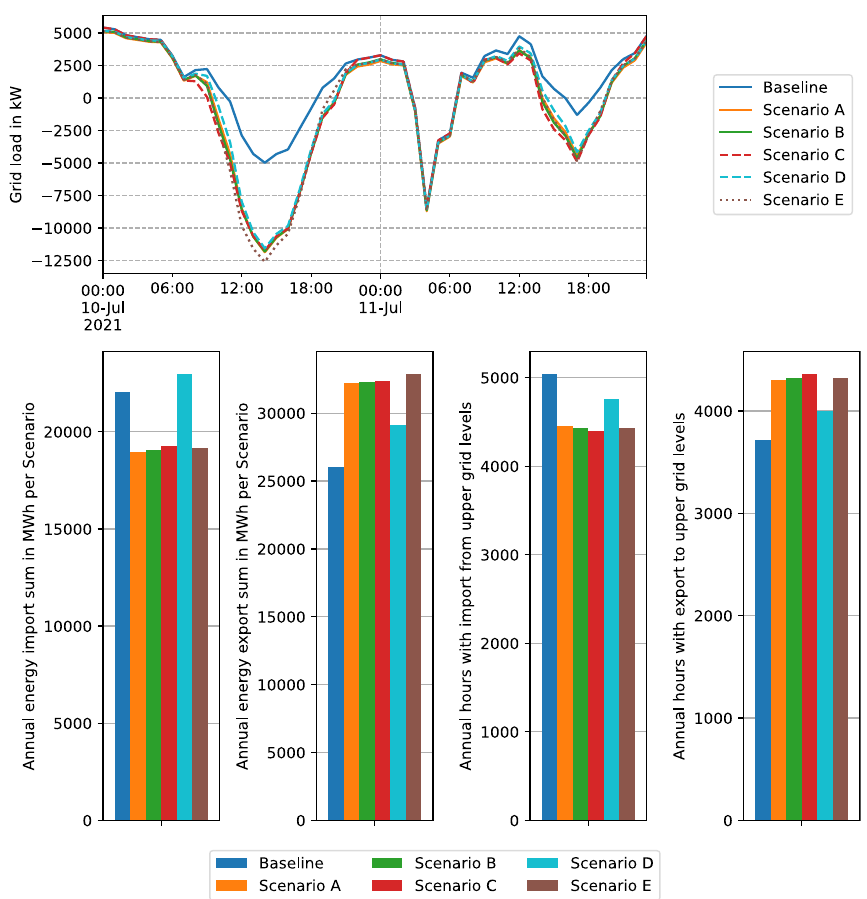
Fig. 11 Analytical plots of the total grid load for different scenarios. Top: Grid load in hourly resolution for two exemplary days with data taken between 10 th until 12 th of July 2021. Bottom: The four graphs show the annual electricity import sum from and export (i.e. feed-in) sum to the upper system level in MWh besides the hours with import from or feed-in to the upper system level per